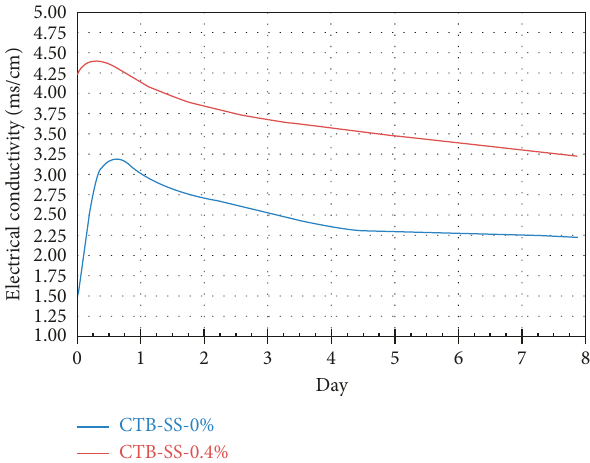
Figure 6: Results of electrical conductivity monitoring of CTB that contains NFS with SS and without